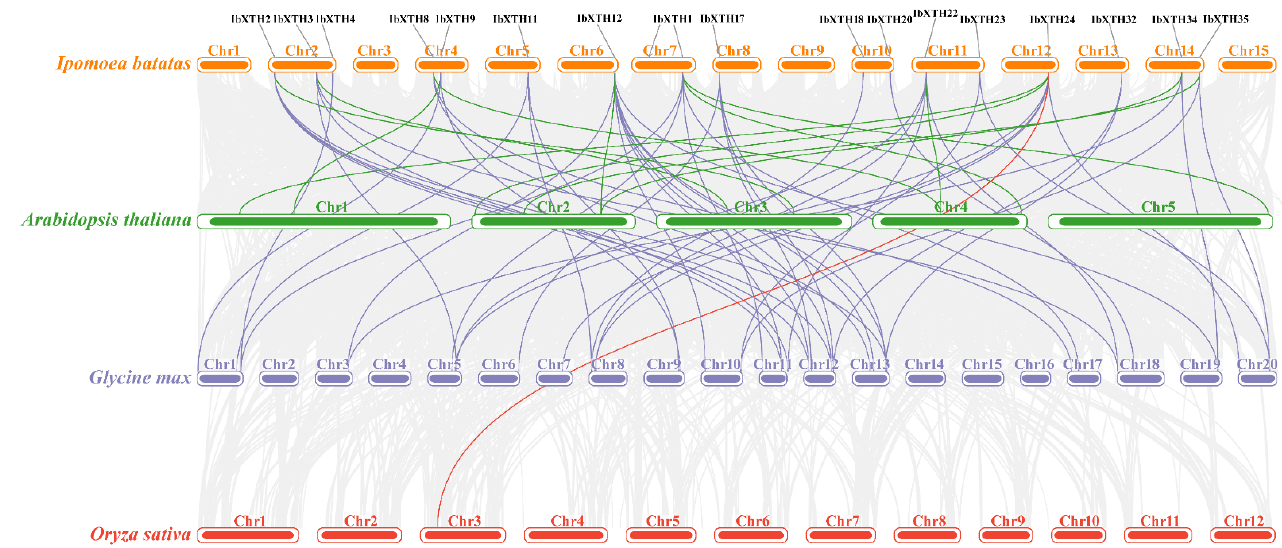
Figure 6. Collinearity analysis of the XTHS from sweet potato and three other species which were analyzed and visualized by Tbtools. The green lines represent XTH syntenic gene pairs between sweet potato and Arabidopsis . The purple lines represent XTH syntenic gene pairs between sweet potato and bean. The red lines represent XTH syntenic gene pairs between sweet potato and rice, and the gray lines represent orthologous genes of sweet potato with three other species.